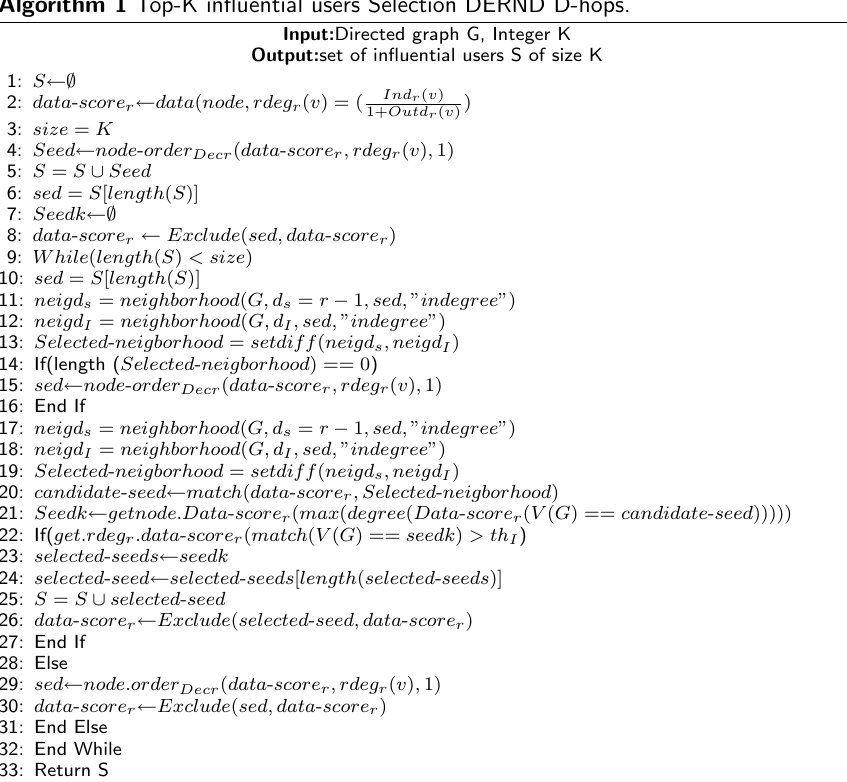
Algorithm 1 Top-K influential users Selection DERND